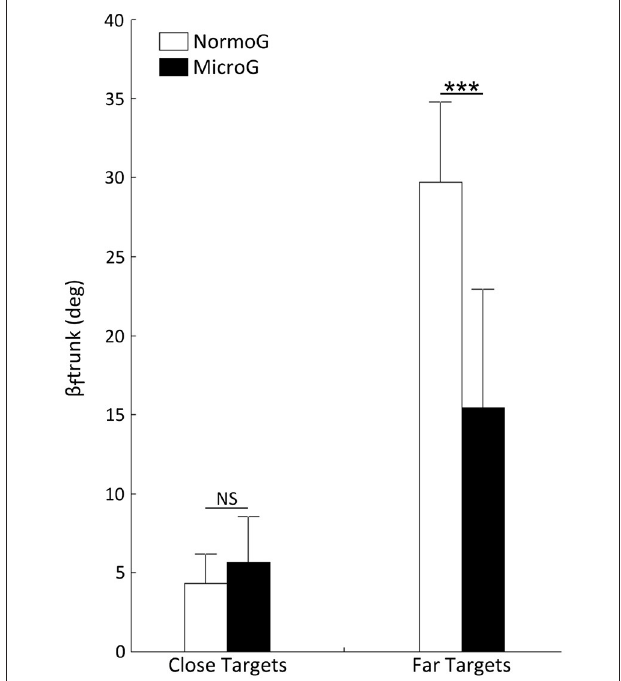
FIGURE 4 | Mean final angular position of trunk relative to vertical ( β f trunk) as a function of Environment and Target Location. Error bars represent standard deviation of the mean. *** p < 0.001; NS, non-significant